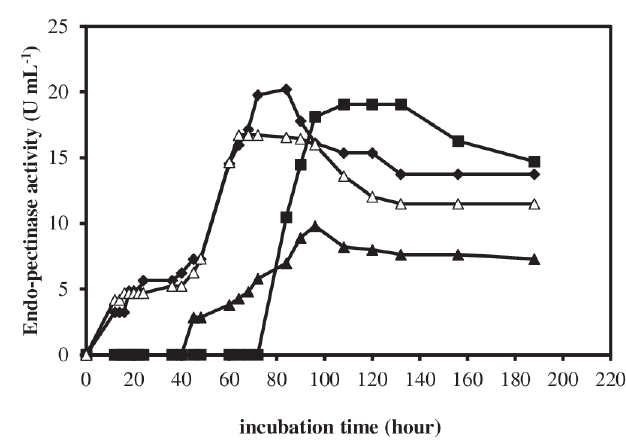
· 2H 0 concentrations on en- 2 2